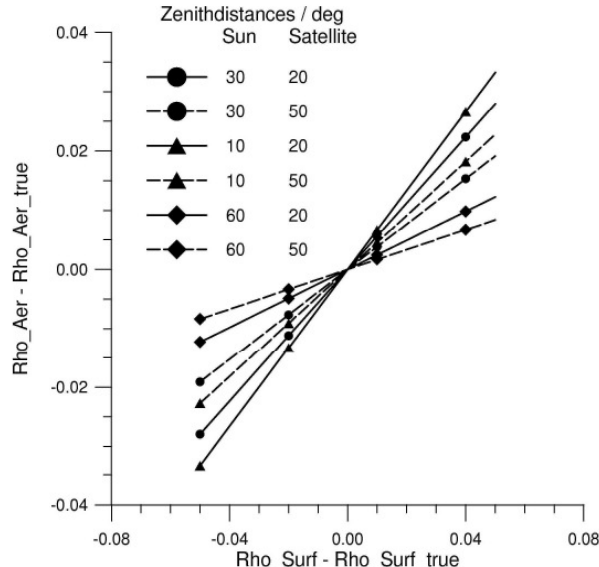
Fig. 5. Sensitivity of aerosol reflectance ρ Aer ( λ) against deviations of surface reflectance ρ Surf ( λ) from true value for selected geometry